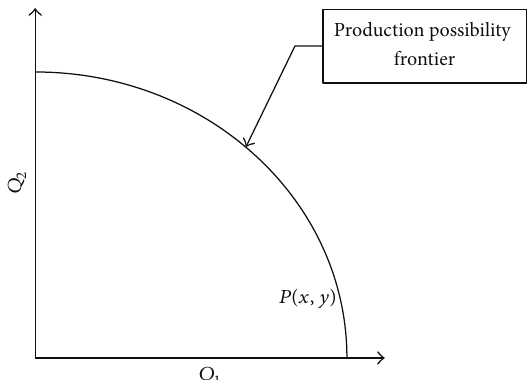
Figure 2: Separation-based distance function and production pos- sibility